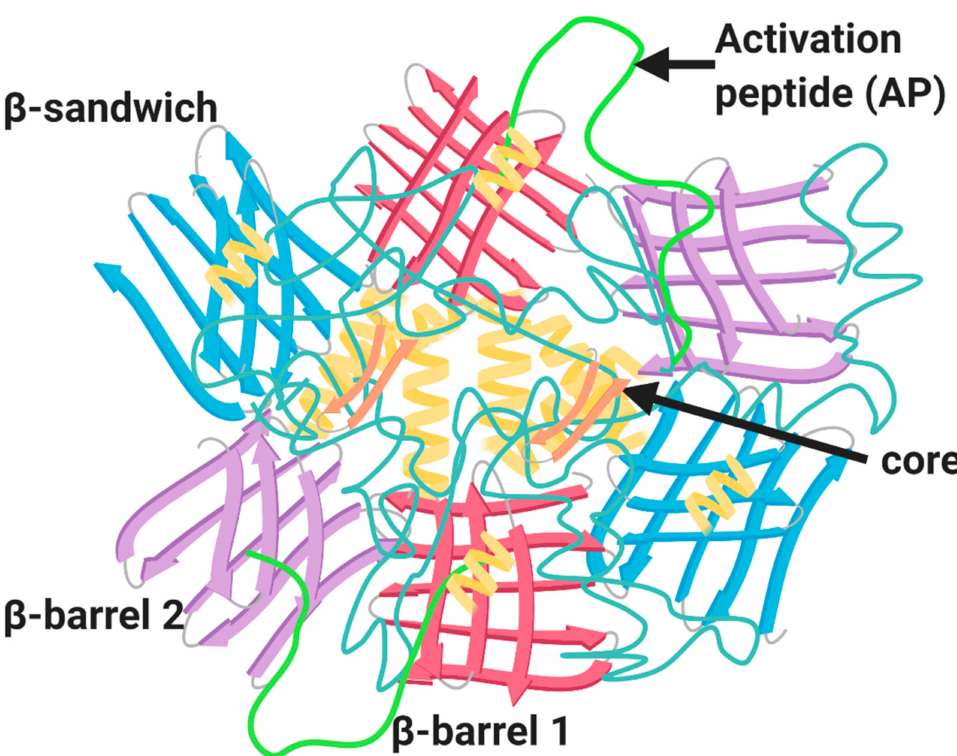
Figure 2. Structure of FXIII-A zymogenic homodimer. The structure of FXIII-A homodimer is composed of four major domains: catalytic core domain (orange), β -sandwich domain (blue), β - barrel-1 domain (red) and the β -barrel-2 domain (purple); alpha helices strands (pale yellow); and the activation peptide (AP)